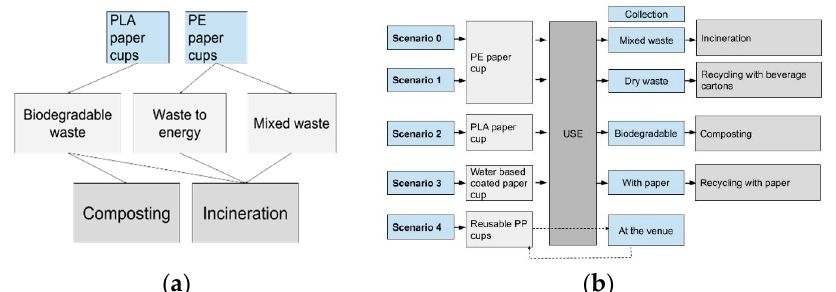
Figure 1. Current and optional waste treatment scenarios: ( a ) Current paper cup sorting and waste treatment at LUT campus; ( b ) alternative paper cup waste management scenarios.